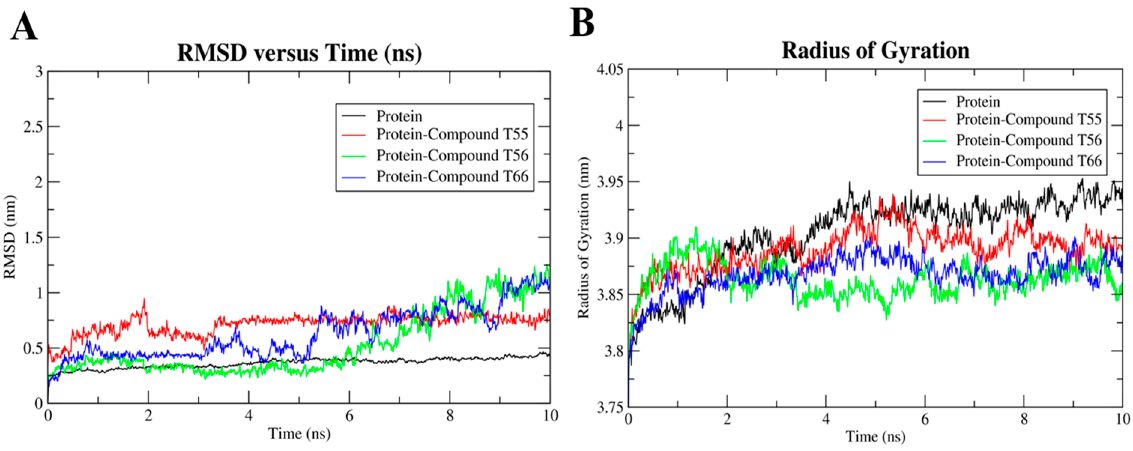
Figure 19. ( A ) Root mean square deviation plot and ( B ) radius of gyration plot of native TLR7 protein and protein–ligand complex over the 10 ns simulation.